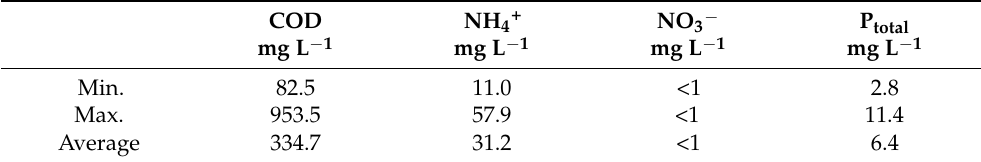
Table 3. Composition of wastewater after primary clarifier (for year 2021, approx. values).